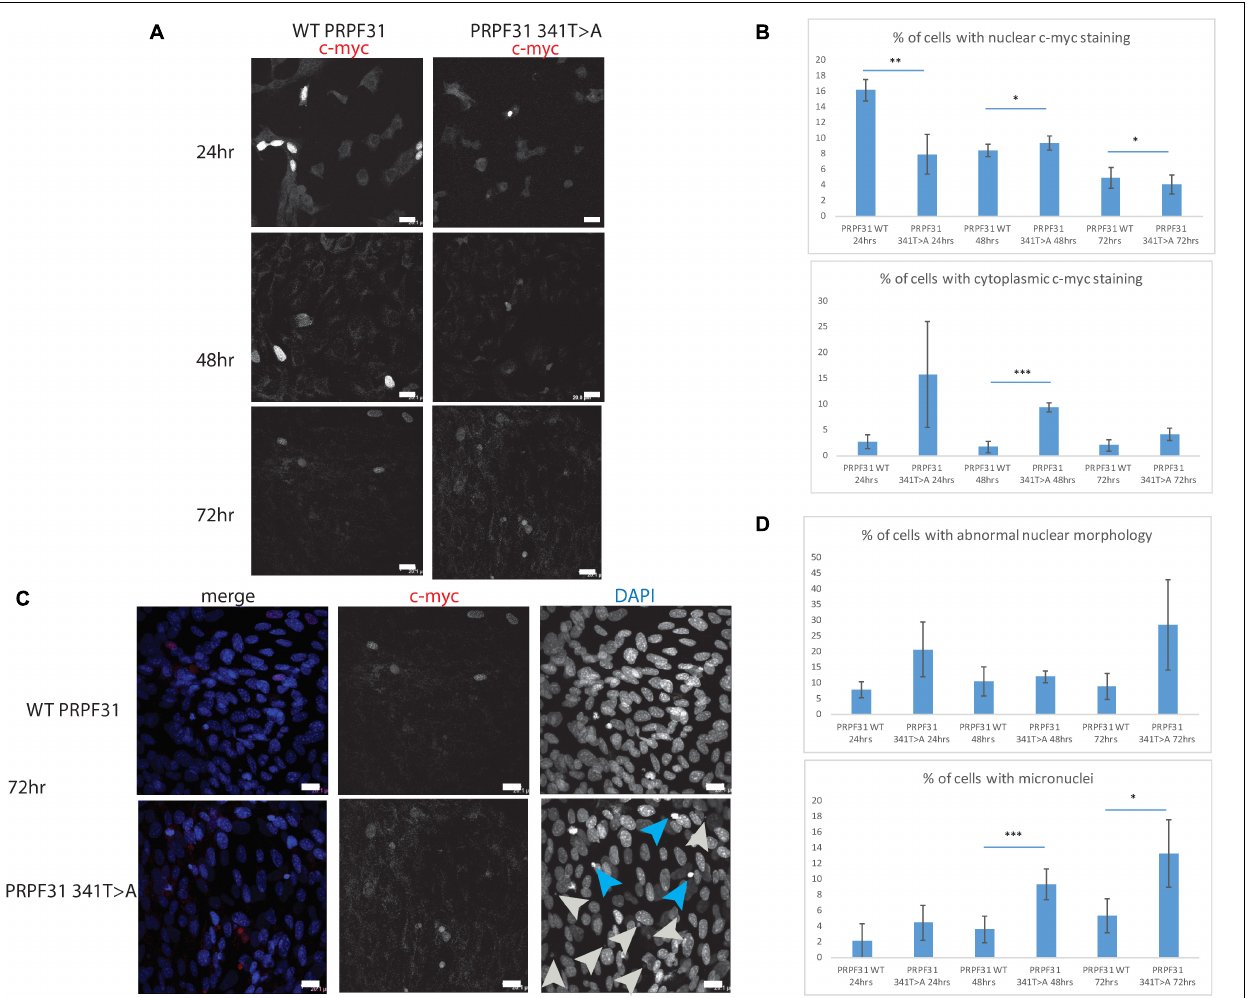
FIGURE 7 | In vitro characterisation of PRPF31 c.341T > A Ile114Asn variant in 661W photoreceptor-like cells. (A) Immunofluorescence confocal images of 661W photoreceptor-like cells transfected with c-myc-tagged wild-type or mutant PRPF31, showing expression and localization of PRPF31-cmyc over 24, 48, and 72 h. c-myc PRPF31 is evenly distributed throughout the nuclei of cells transfected with WT plasmid at each time point, but is concentrated in the nuclei of a few cells in 661W cells transfected with the mutant plasmid, with some cytoplasmic staining. Scale bars = 20 µ m. (B) Graphs and statistical significance of proportions of cells with nuclear and cytoplasmic c-myc staining after transfection with WT and 341T > A mutant PRPF31. ∗ p < 0.05, ∗∗ p < 0.01, ∗∗∗ p < 0.001, n = 3. Error bars show standard error of the mean. (C) At 72 h, nuclear staining shows many micronuclei (gray arrows) and nuclei with abnormal morphology (blue arrows) in the cells transfected with mutant PRPF31. Scale bars = 20 µ m. (D) Graphs and statistical significance of proportions of cells with abnormal nuclei morphology and micronuclei. ∗ p < 0.05, ∗∗∗ p < 0.001, n =